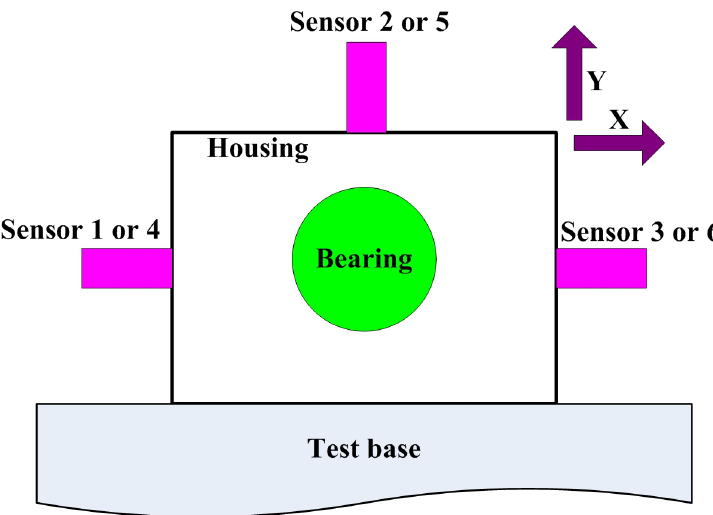
Figure 4. Sensor installation